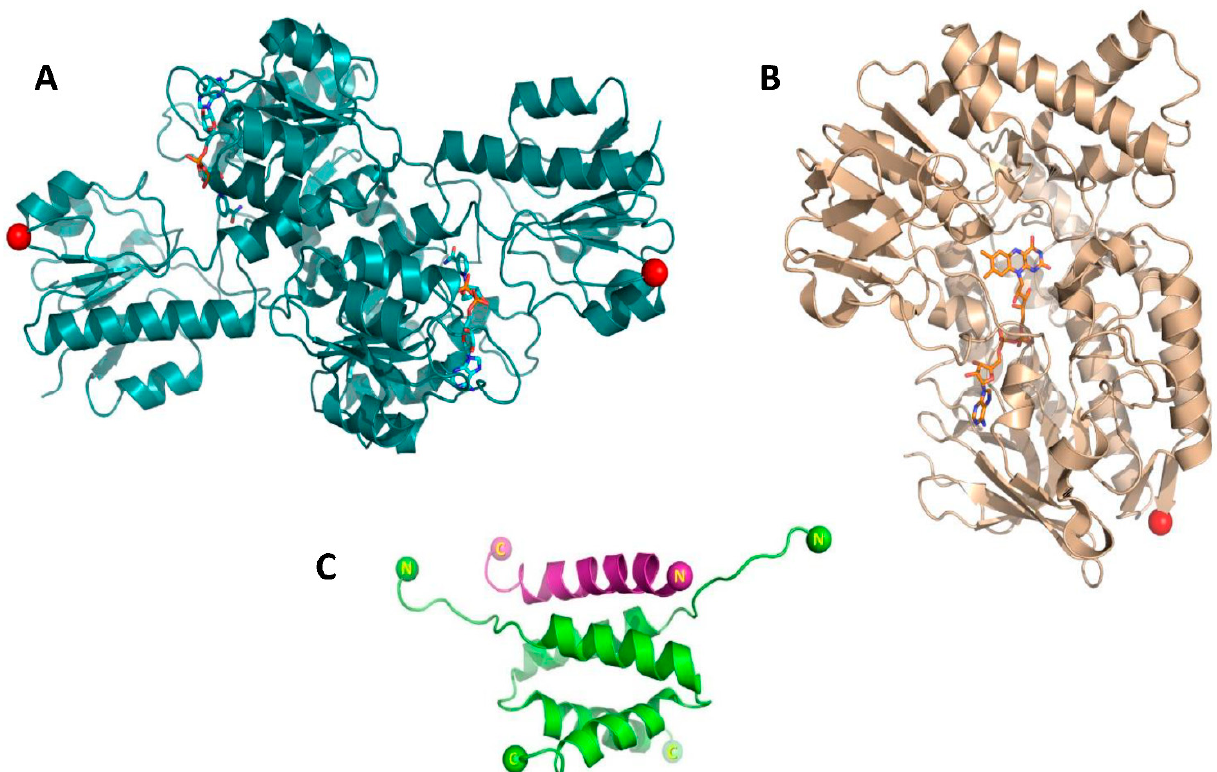
Figure 1. ( A ) Structure of dimeric PTDH, with NAD + in cyan sticks; ( B ) Structure of monomeric PAMO with FAD in orange sticks. The C-termini are indicated with red spheres; ( C ) Structure of the docking and dimerization domain (RIDD, in green) of regulatory subunit of protein kinase A in complex with a peptide from an A-kinase anchoring protein (RIAD, in purple). The figures were prepared using PyMol, using PDB:2DRN, PDB:4E5P and PDB:1W4X, respectively.